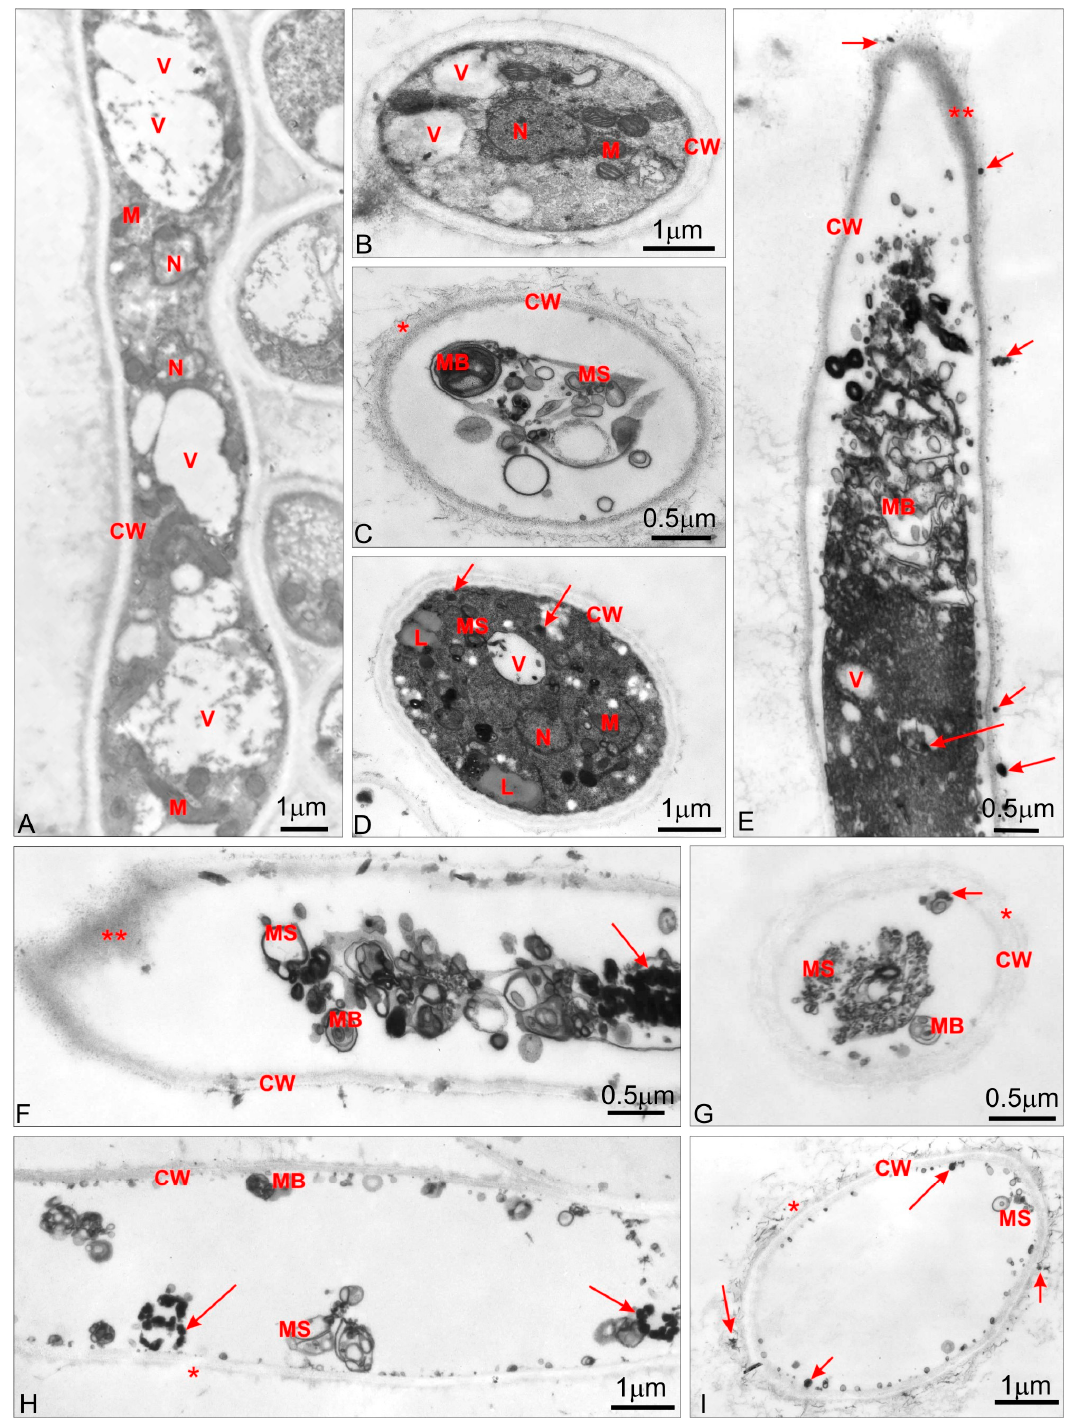
Figure 2. ( A , E , F , H ) TEM micrographs of longitudinal-sections and ( B – D , G , I ) cross-sections of Aspergillus brasiliensis : ( A , B ) control hyphae; ( C – E ) hyphae treated with hexamethylene-1,6-bis-( N , N - dimethyl- N -dodecylammonium bromide) C6 for 48 h at 0.5 MIC; ( F , G ) hyphae treated with C6 for 48 h at MIC and ( H , I ) hyphae treated with C6 for 48 h at 2 MIC. CW—cell wall; L—lipid; M—mitochondrion; MB—multivesicular body; MS—membranous structure; N—nucleus; V—vacuole; arrows-electron-dense deposit.